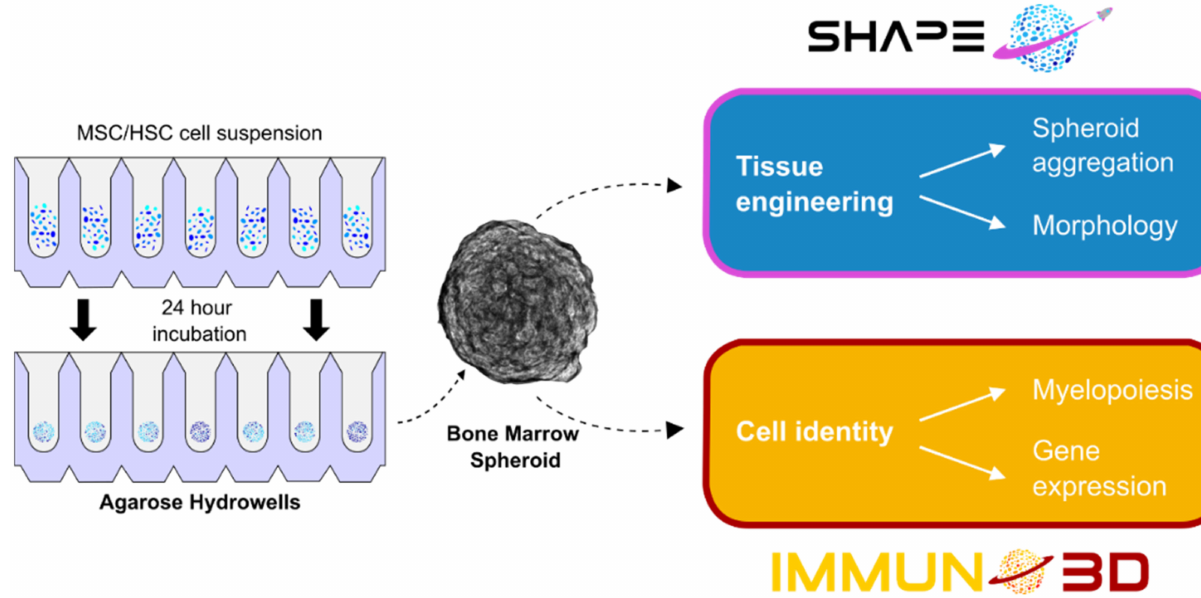
Figure 6. Overview of the upcoming SHAPE and IMMUNO3D projects. Both experiments use large numbers of bone marrow spheroids containing HSC and MSC generated in self-designed agarose Hydrowells in spaceflight. SHAPE is intended to lay a foundational knowledge base for spheroid cultures in space by analysing spheroid formation and morphology. IMMUNO3D aims to investigate myelopoiesis by examining the changes in gene expression, cell identity, and the changes in the proportion of the two cell types within the